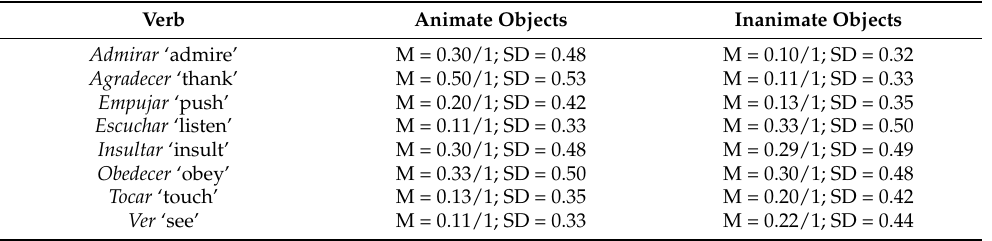
Table 7. DOM use across test items and conditions within the participants who produced some non-animacy-driven a -marking in the Spanish